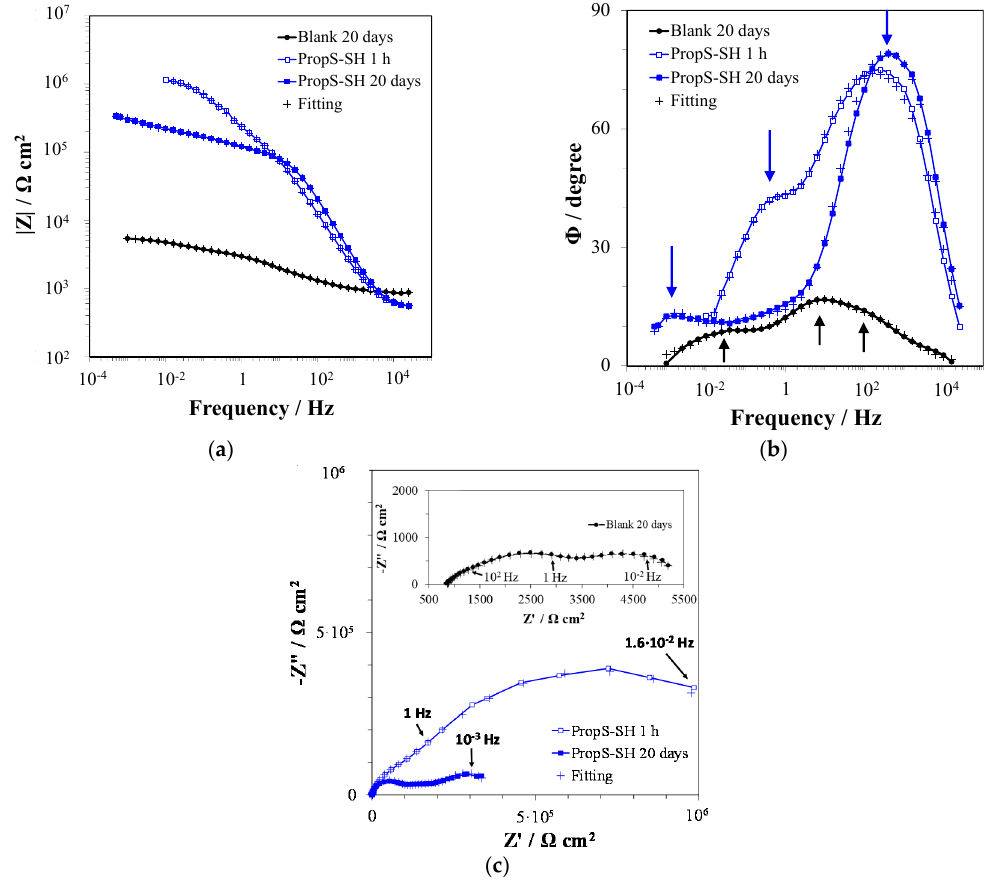
Figure 7. Bode ( a , b ) and Nyquist ( c ) plots recorded on bare and PropS-SH coated bronze in AR × 10 at 30 °C. Squares and circles represent experimental data and crosses are the result of the fitting.